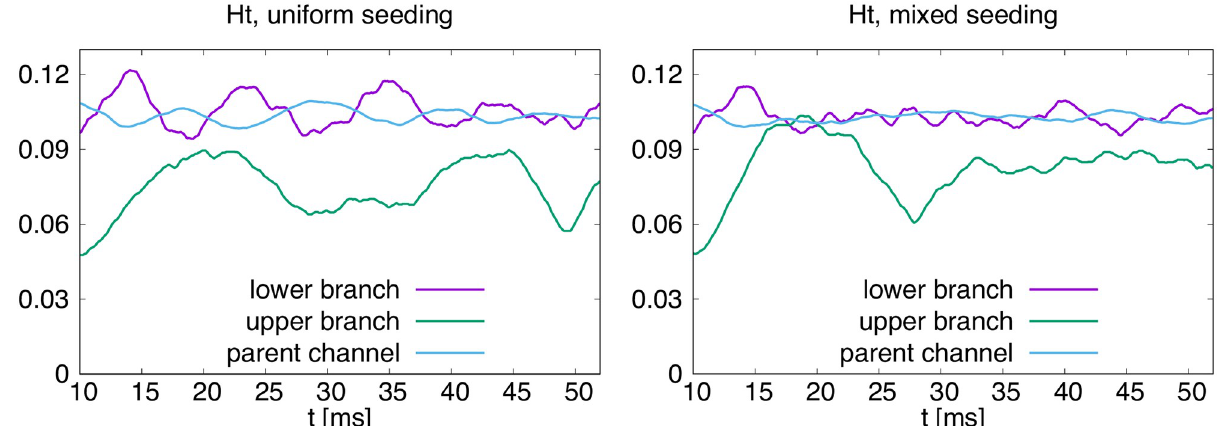
Fig 5. Hematocrit in the main parent channel and two daughter branches averaged over 10ms. In the uniform seeding, all red blood cells had the same elastic properties as calibrated using the stretching experiment. In the mixed seeding, the cells were placed at the same starting positions, but randomly selected half of them were significantly stiffer.